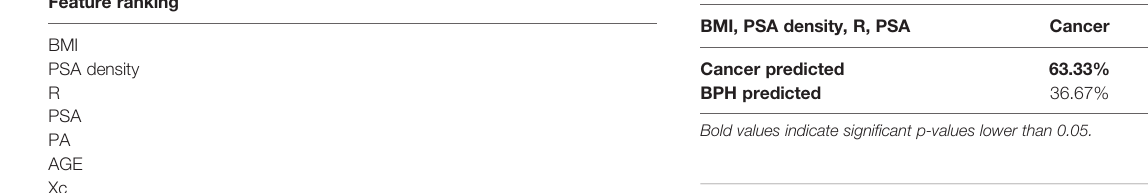
TABLE 8 | Comprehensive ranked clinical feature list of the most accurate subset of features: BMI, PSA density, RES, and PSA.